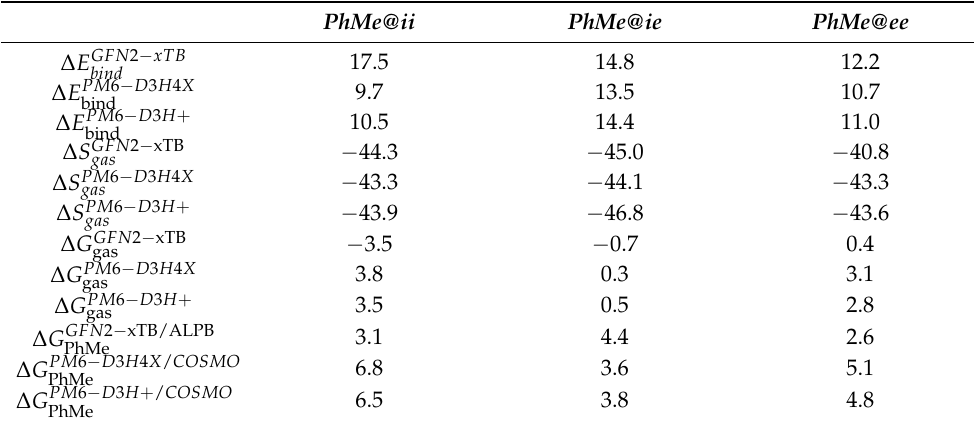
Table 5. Binding energies, enthalpies (gas), entropies (gas) and Gibbs free energies (gas and in toluene) for the formation of aggregates between the conformers of C 60 H 28 corannulene pincers with toluene, in which the latter is caged within the former. Thermodynamic data were calculated at 300 K, all energies are in units of kcal/mol, whereas entropies are in units of cal K − 1 mol − 1 .